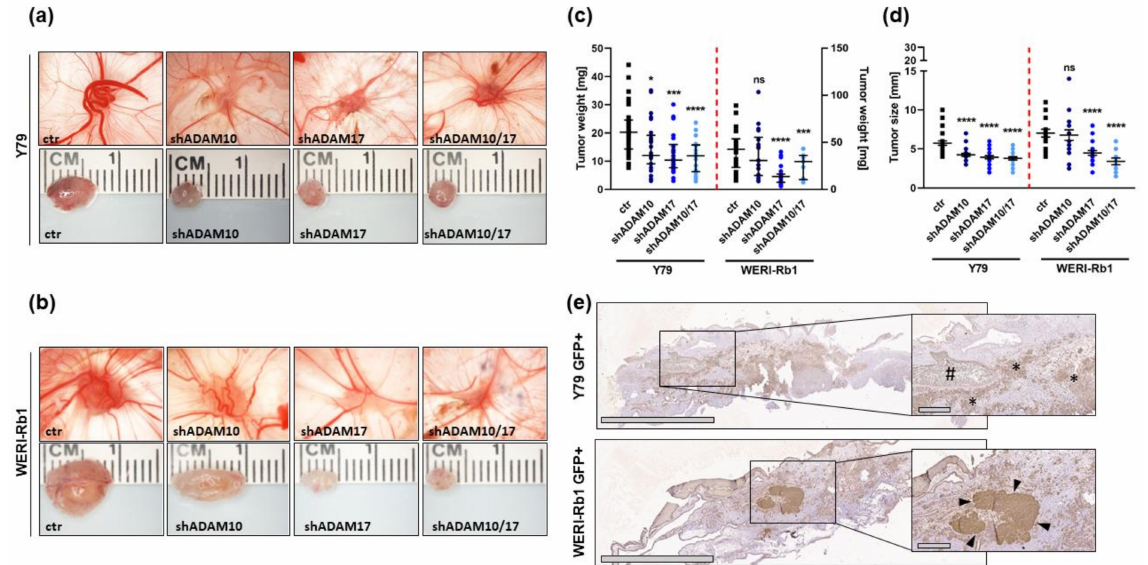
Figure 6. Effect of lentiviral ADAM10/17 single and double knockdown on tumor formation of RB cell lines in vivo as revealed by chick chorioallantoic membrane (CAM) assays. Photographs of CAM tumors in situ (upper row) and ruler measurements (in cm) of excised CAM tumors (lower row) 7 days after inoculating the Y79 ( a ) and WERI-Rb1 ( b ) RB cell onto the CAM. Quantification of weight ( c ) and size ( d ) of CAM tumors developing from ADAM10 (shADAM10), ADAM17 (shADAM17) and ADAM10/17 (shADAM10/17) depleted Y79 and WERI-Rb1 cell lines in comparison the control cells (ctr). Values are means of at least three independent experiments ± SEM. ns p > 0.05; * p < 0.05; *** p < 0.001; and **** p < 0.0001 statistical differences compared to the control group calculated by Student’s t -test. ( e ) GFP antibody staining of stably GFP expressing Y79 and WERI-Rb1 cells in CAM tumor paraffin sections. Immunohistochemistry was revealed using diaminobenzidine (brown signal) and hematoxylin counterstaining (blue nuclei staining). Scale bars, 2 mm and 300 µ M (magnified insets). #: blood vessel in CAM mesoderm, *: GFP-positive (GFP+) RB tumor cells, arrowheads: solid GFP-positive RB tumor mass.